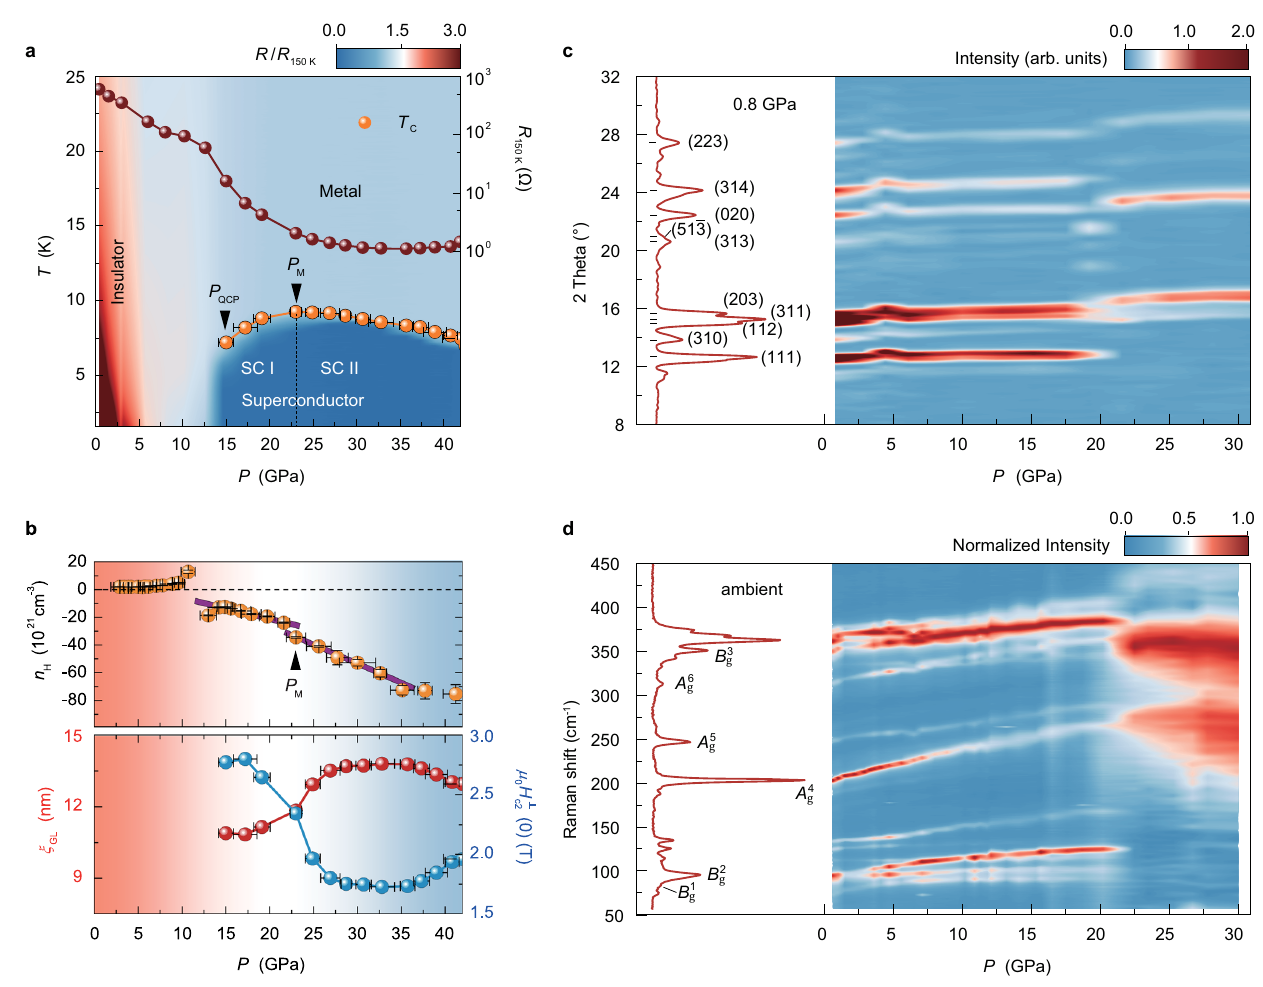
Fig. 2 | PhasediagramofthesuperconductivityofGePand itsstructuralphase transition under pressure.a Colormapping of the normalizedresistance R = R 150K asafunctionoftemperatureand pressurefor GeP (sample1).The insulating phase isshadedinred,andthesuperconductingphases(SCIandSCII)areshadedinblue. The orange balls represent the superconducting critical temperature T c , which is de fi ned asthetemperatureatwhichresistancedropsto90%ofthe R N ( R N denotes the resistance of the normal state at 14K). The pressure corresponding to the insulator-superconductor transition is denoted as the quantum critical pressure P fi ned by the critical pressure where the structural phase transition P QCP . M is de occurswith maximum T c and can be used to distinguish SC I and SCII phases. The dark red balls denote the resistancevalues at150K. The error barson pressureare determined by the differences in fl uorescence lines at different positions on the same ruby. b Top panel presents the carrier density as a function of pressure for sample 2 at 1.5K. The carrier density is deduced from the Hall effect measured at 1.5Kbyapplyingmagnetic fi eldsto±8T(largerthanthe H c2 ,whichisde fi nedasthe